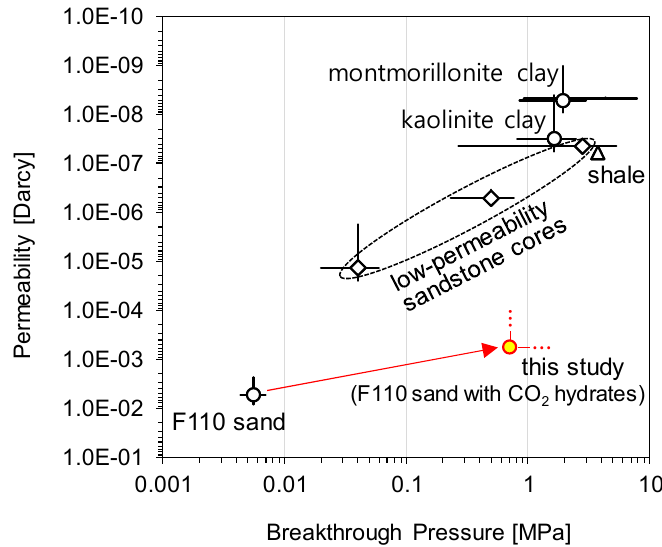
Figure 13. Absolute permeability and breakthrough pressure of various consolidated and unconsolidated sediments and estimated values in this study. Filled circle represents estimated values of minimum breakthrough pressure and maximum permeability of CO 2 hydrate-bearing sediments. Hollow circles represent F110 sand, kaolinite clay, and montmorillonite clay [42], hollow diamonds represent low-permeability sandstone cores [43], and hollow triangle represents shale [44]. The vertical and horizontal bars indicate the range of the measured values.